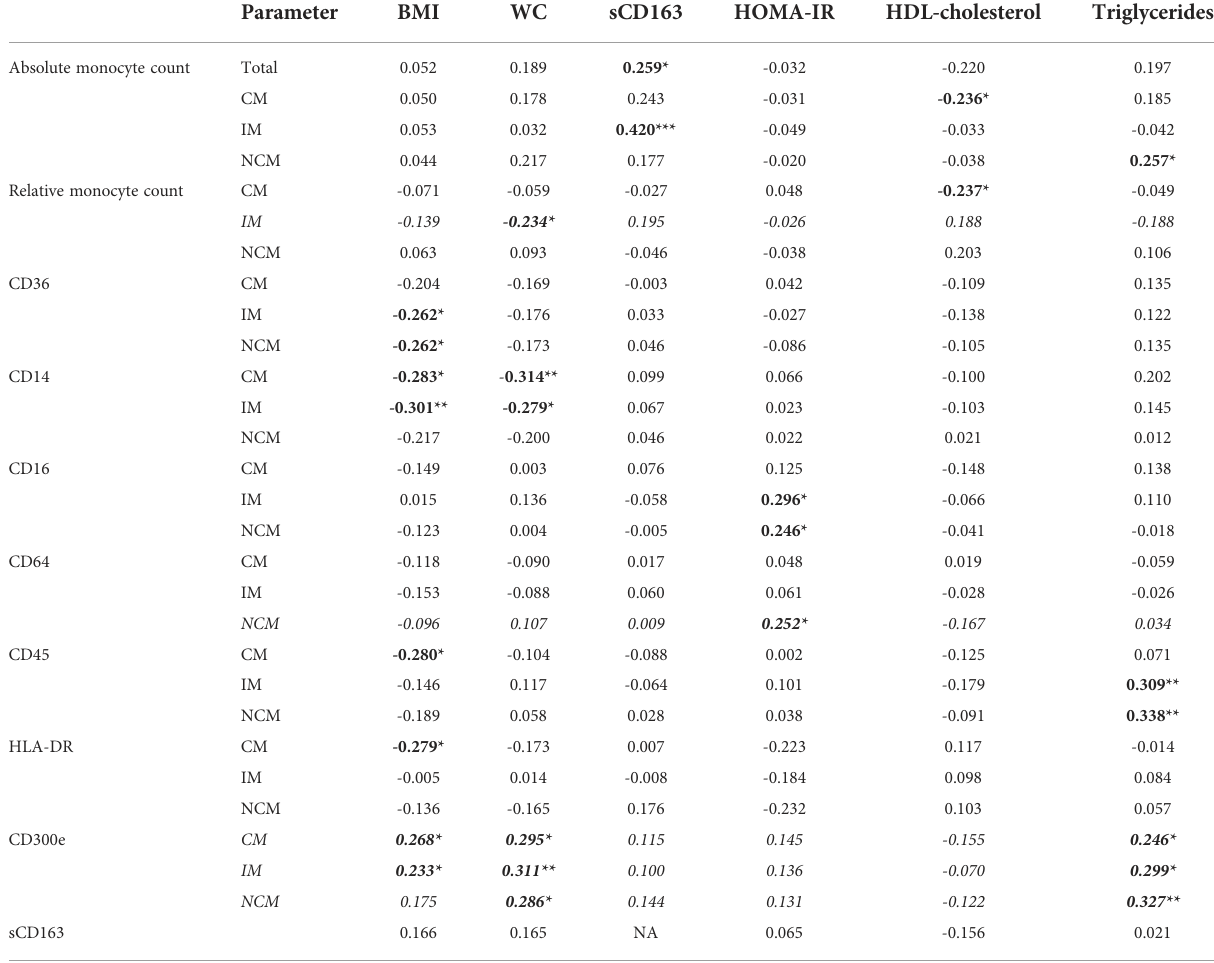
TABLE 3 Correlation between monocyte characteristics and relevant obesity parameters at